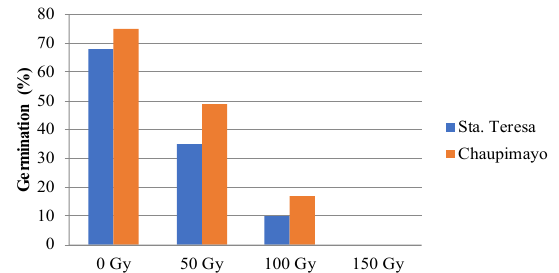
Figure 2. Percentage of germination of coffee ( Coffea arabica L. var. typica) seeds originating from Santa Teresa and Chaupimayo under net house conditions at 75 days after sowing following irradiation with gamma rays at 0 (control), 50, 100, and 150 Gy.